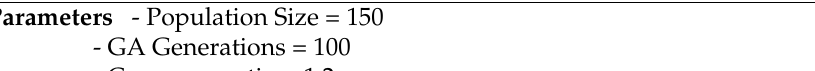
Algorithm 1 Algorithm Solving Optimization